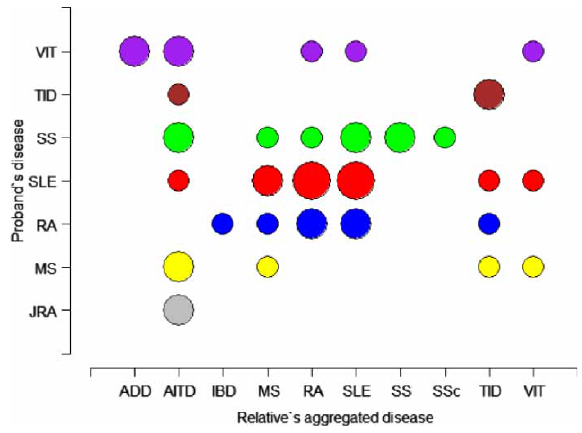
Figure 2. Familial autoimmunity clusters. The ordinate represents the proband’s disease, while the axis despites the correspondent aggregated AD. Circle size represents the weighted analyzed reports and does not necessarily indicate the aggregation’s magnitude. This figure was generated from Table I data. JRA, juvenile rheumatoid arthritis; MS, multiple sclerosis; SS, Sjo¨gren’s syndrome; RA, rheumatoid arthritis; SLE, systemic lupus erythematosus; T1D, type 1 diabetes mellitus; VIT, vitiligo; AITD, autoimmune thyroid